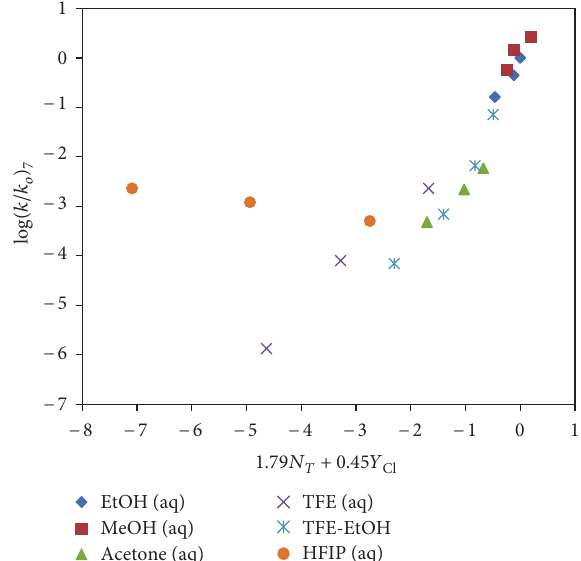
F 5: e plot of log for 4-chlorophenyl chlorothionofor- + 0.45 in the nineteen pure and binary mate ( 7 ) against 1.79 Cl O and HFIP-H O are not solvents studied. e points for TFE-H (𝑘𝑘𝑘𝑘𝑘 𝑜𝑜 ) included in the correlation. ey are added to show the extent of 𝑌𝑌 𝑁𝑁 𝑇𝑇 𝑙 𝑙 their deviation from the